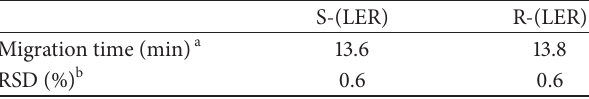
Table 2: Electrolysis test of BGE for LER enantiomers analysis. S-(LER) R-(LER) Migration time (min) a 13.6 13.8 RSD (%) b 0.6 0.6 a number of determination ( 𝑛 ) = 5, b RSD (%): relative standard deviation expressed as a percentage.